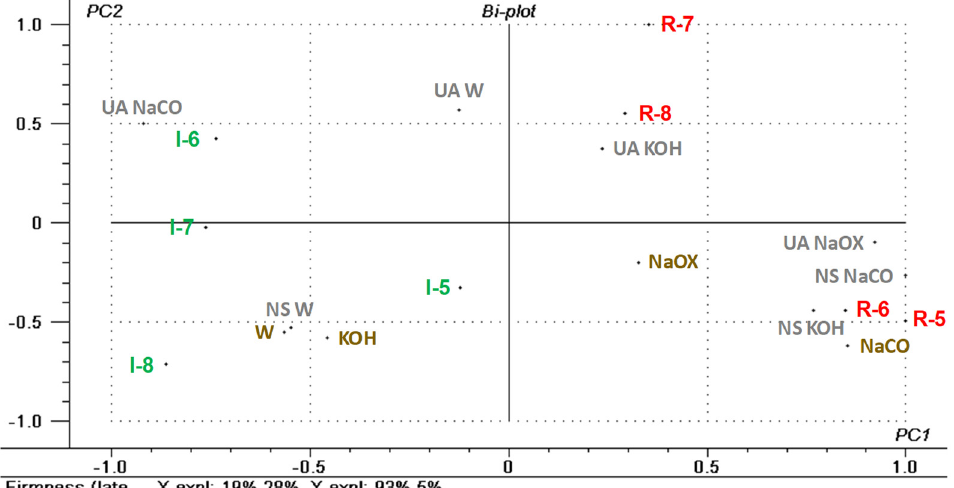
Figure 5. Biplot (scores and loadings) of PC1 vs. PC2 corresponding to a Partial Least Squares Regression (PLSR) model for ‘Arbequina’ fruit firmness ( Y variable) vs. yield and composition of different cell wall fractions ( X variables). Codes 5 to 8 denote successive picking dates throughout on- tree fruit maturation under irrigated ( I ) and rainfed ( R ) conditions (Abbreviations: W, water-soluble fraction; NaOX, sodium oxalate-soluble fraction; NaCO, sodium carbonate-soluble fraction; KOH, potassium hydroxide-soluble fraction; UA, uronic acid content; NS, neutral sugar content).